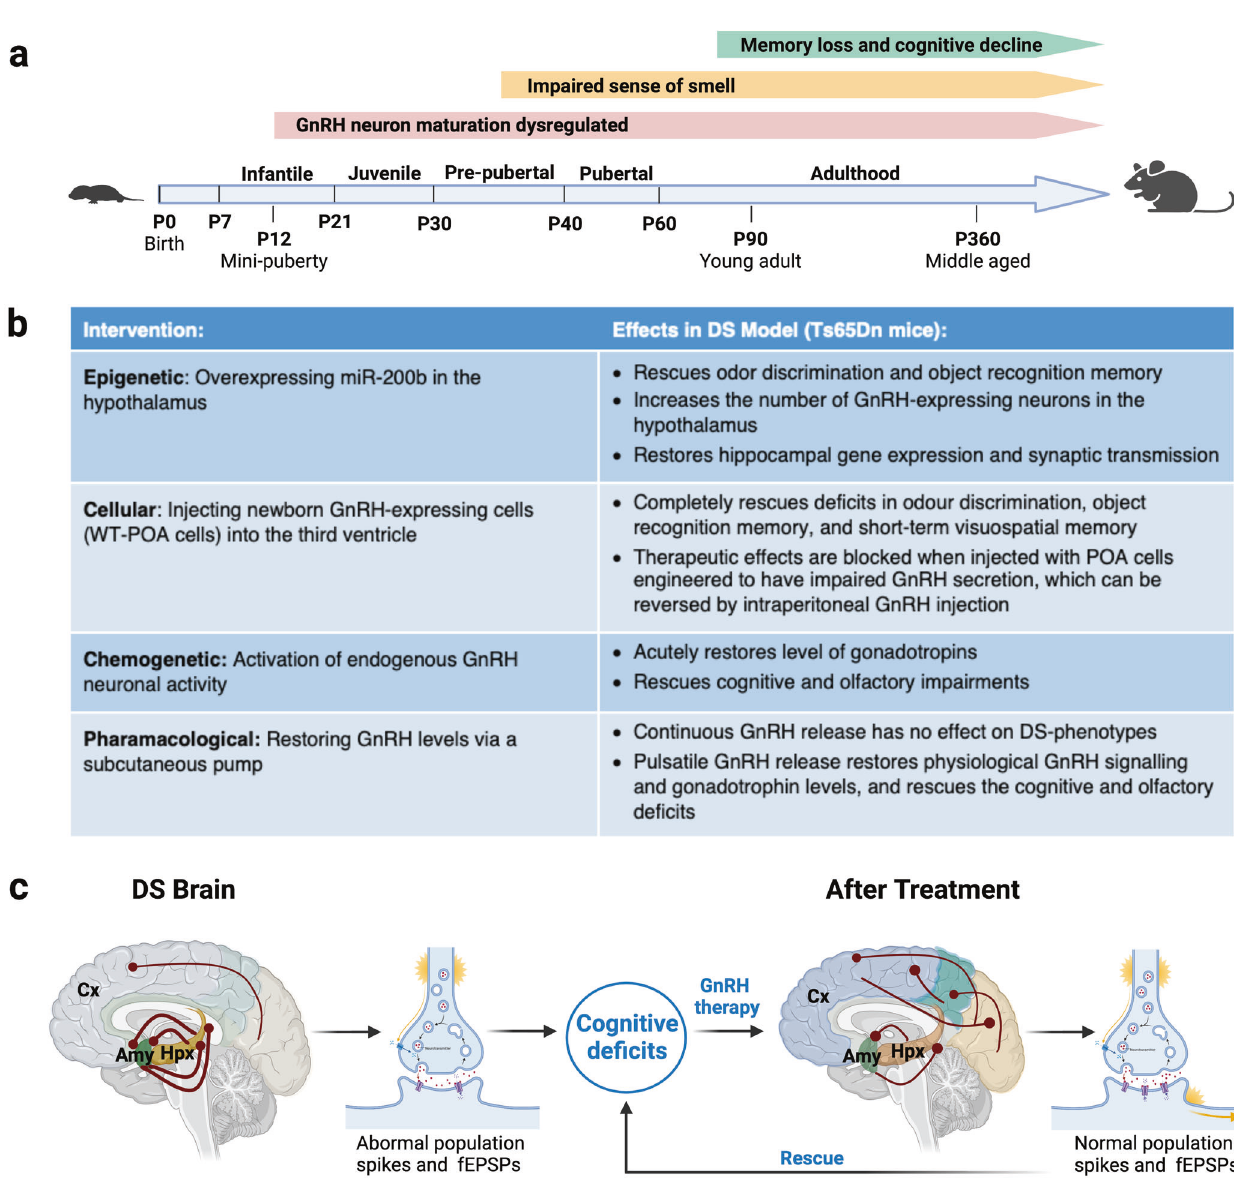
Fig. 1 The therapeutic effects of GnRH in DS. a Developmental timeline showing the onset and progression of pathology in Ts65Dn mice, as reported in the highlighted paper. b Summary of the intervention strategies to rescue GnRH and their therapeutic effects in Ts65Dn mice. c Diagram showing how GnRH could boost cognition in humans. GnRH therapy may restore network dysfunction in the brain by strengthening the connectivity between cortical areas (Cx) that are hypoconnected in DS, and weakening abnormally hyperconnected subcortical areas, such as the hippocampus (Hpx) and amygdala (Amy). GnRH may also act to improve information processing at the cellular level by modulating neuronal excitability. Image created with BioRender.com. WT-POA wild-type pre-optic area, fEPSPs functional